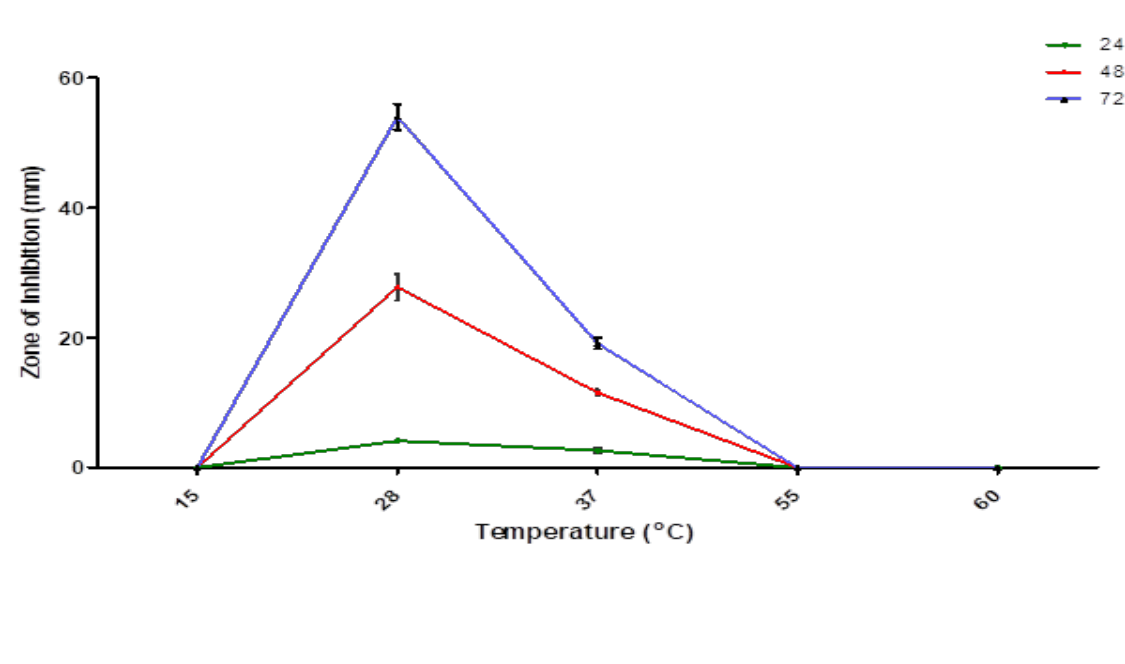
Figure 2. Effect of temperature on the haemolytic activity of Alcaligenes